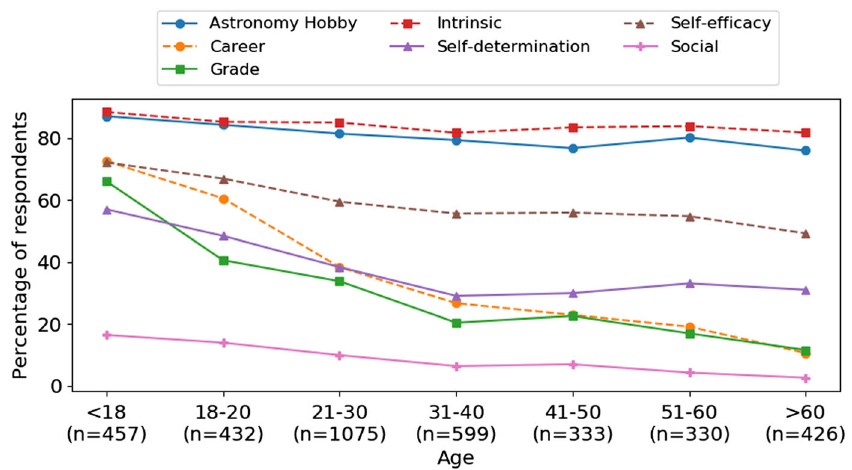
FIG. 4. Percentages of survey respondents in the high tier of each motivational category as a function of age of the